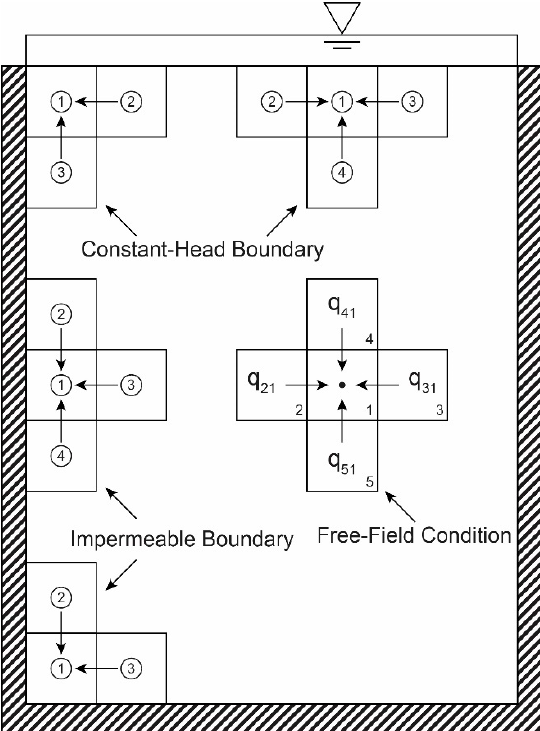
Figure 2. Visualization of all boundary conditions used in the fluid modeling experiments, where q denotes flow between adjacent cells.